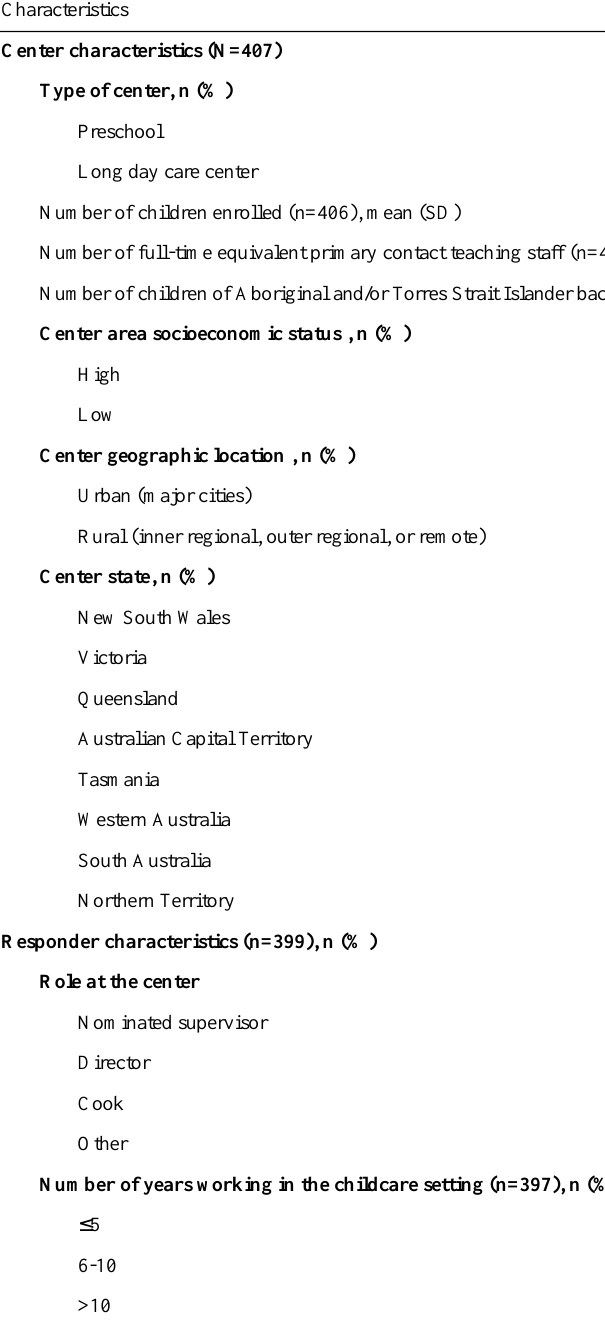
Table 2. Childcare center and responder